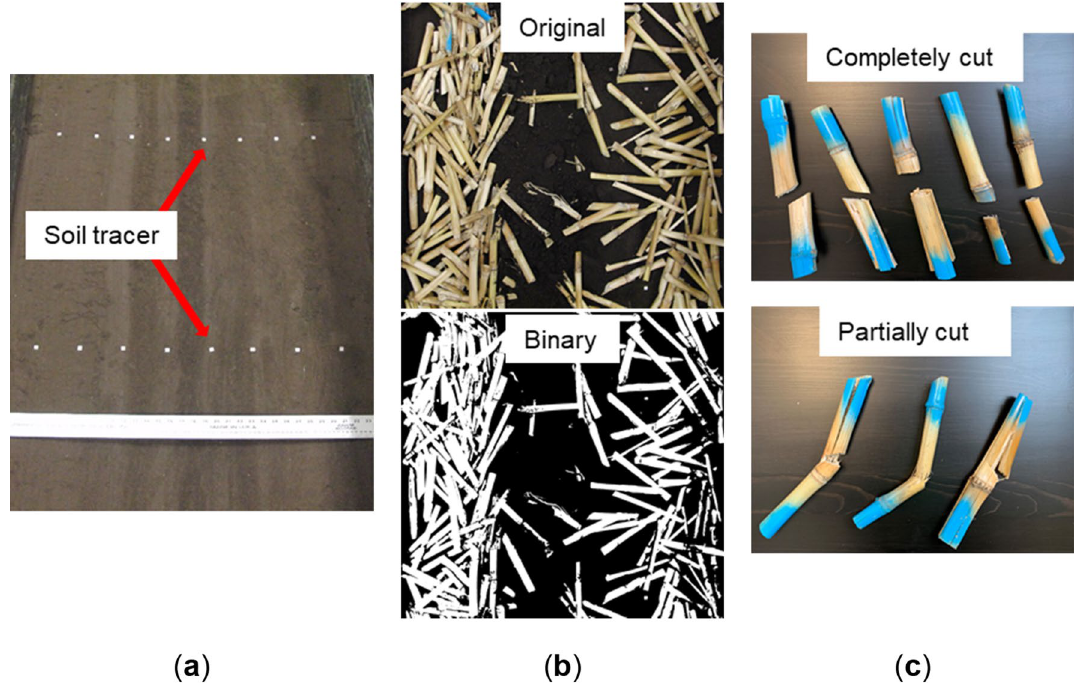
Figure 7. Soil bin test measurements: ( a ) soil tracers used for monitoring soil displacements, ( b ) original image and binary image for measuring residue mixing, ( c ) sample residue tracers demonstrating two different residue cutting scenarios, completely and partially